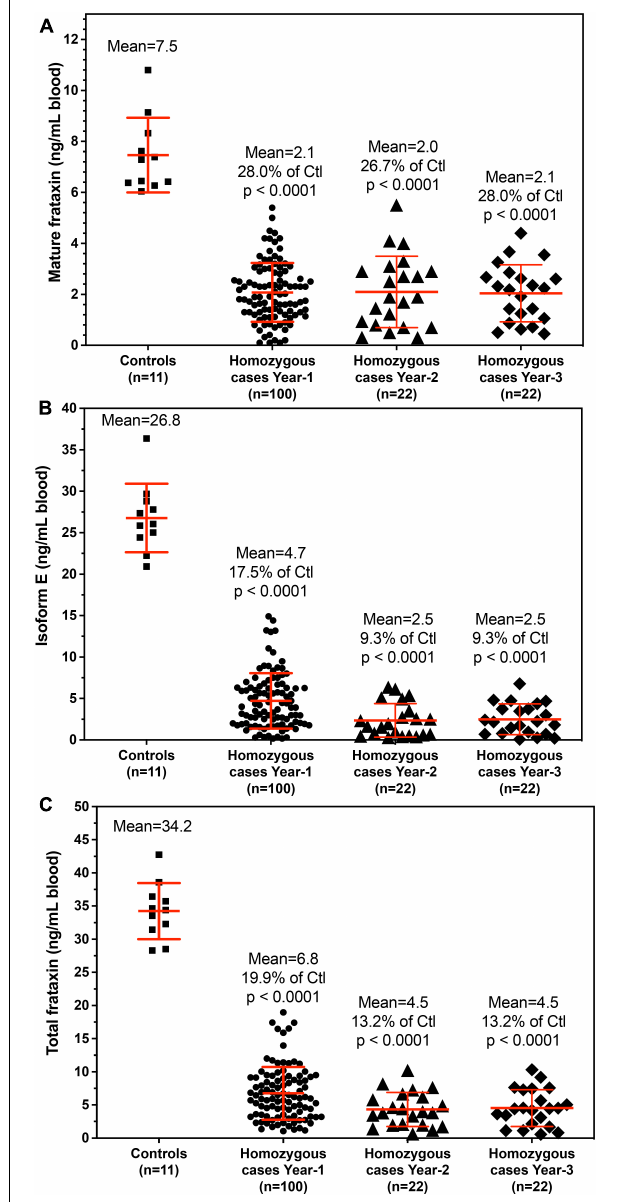
FIGURE 4 | Whole blood frataxin levels in healthy controls and homozygous FRDA patients as means ± standard deviation. (A) Mature frataxin. Healthy controls 7.5 ± 1.5 ng/mL blood ( n = 11), homozygous cases in year-1 2.1 ± 1.2 ng/mL blood ( n = 100, p < 0.0001), homozygous FRDA patients in year-2 2.1 ± 1.4 ng/mL blood ( n = 22, p < 0.0001), homozygous FRDA patients in year-3 2.0 ± 1.1 ng/mL blood ( n = 22, p < 0.0001). (B) Frataxin isoform E. Healthy controls 26.8 ± 4.1 ng/mL blood ( n = 11), homozygous FRDA patients in year-1 4.7 ± 3.3 ng/mL blood ( n = 100, p < 0.0001), homozygous FRDA patients in year-2 2.5 ± 2.0 ng/mL blood ( n = 22, p < 0.0001), homozygous FRDA patients in year-3 2.5 ± 1.9 ng/mL blood ( n = 22, p < 0.0001). (C) Total frataxin. Healthy controls 34.2 ± 4.2 ng/mL blood ( n = 11), homozygous FRDA patients in year-1 6.8 ± 4.0 ng/mL blood ( n = 100, p < 0.0001), homozygous FRDA patients in year-2 4.5 ± 2.6 ng/mL blood ( n = 22, p < 0.0001), homozygous FRDA patients in year-3 4.5 ± 2.8 ng/mL blood ( n = 22, p < 0.0001). Homozygous FRDA patients were compared with healthy controls using an unpaired two-tailed t